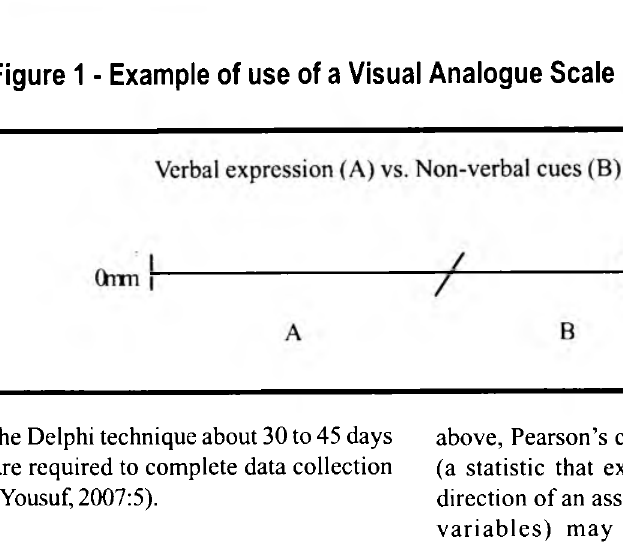
Figure 1 - Example of use of a Visual Analogue Scale